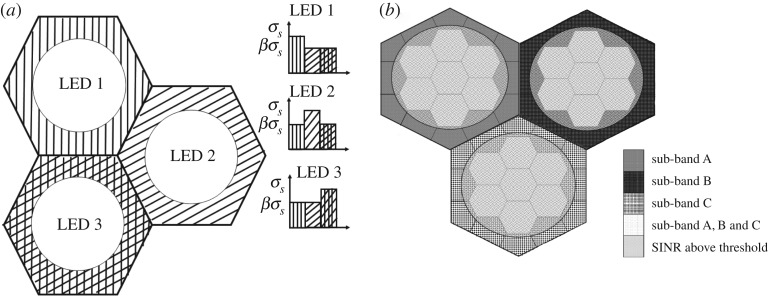
Cell planning. (a) Colour cell planning [86] and (b) FFR [85].